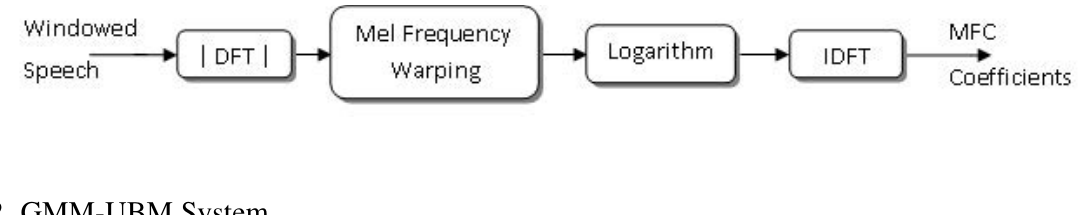
Figure 5. Steps of computing mel frequency cepstral coefficient (MFCC)